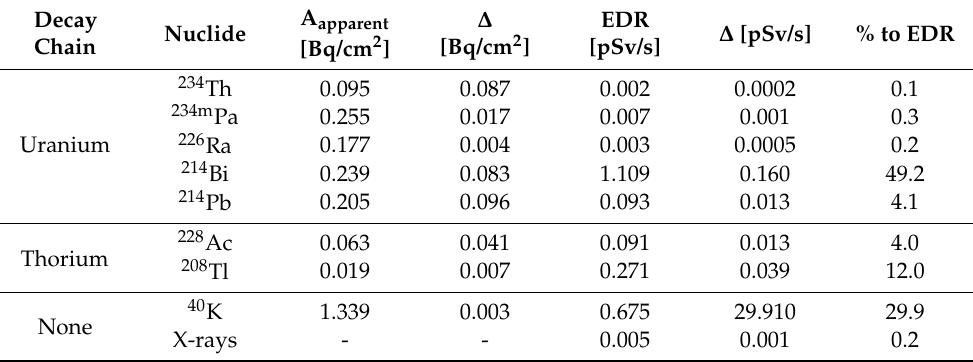
Table 2. Total apparent activity and effective dose rate (EDR) associated with each source of pho- ton radiation recognized at the spectrum registered in situ. The relative contribution (%) to each radionuclide to EDR is also